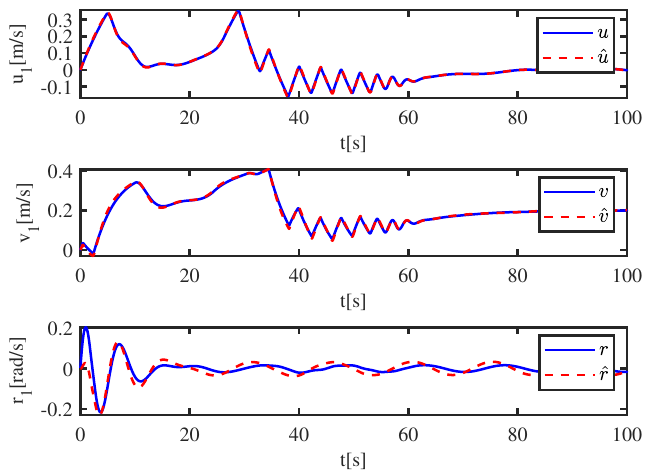
Figure 5. Velocity